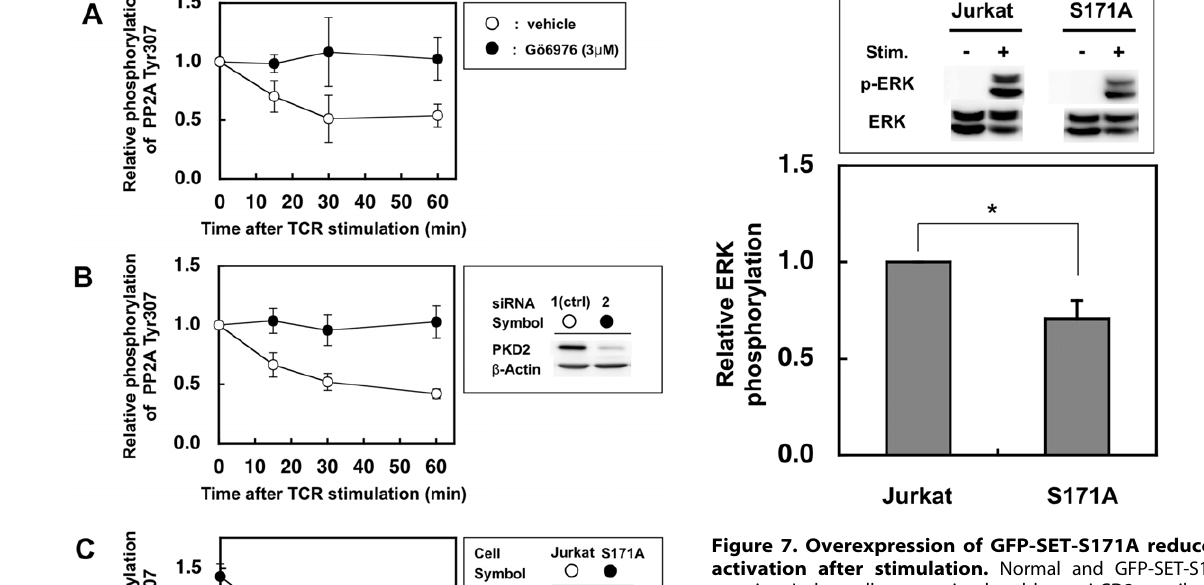
independent experiments.